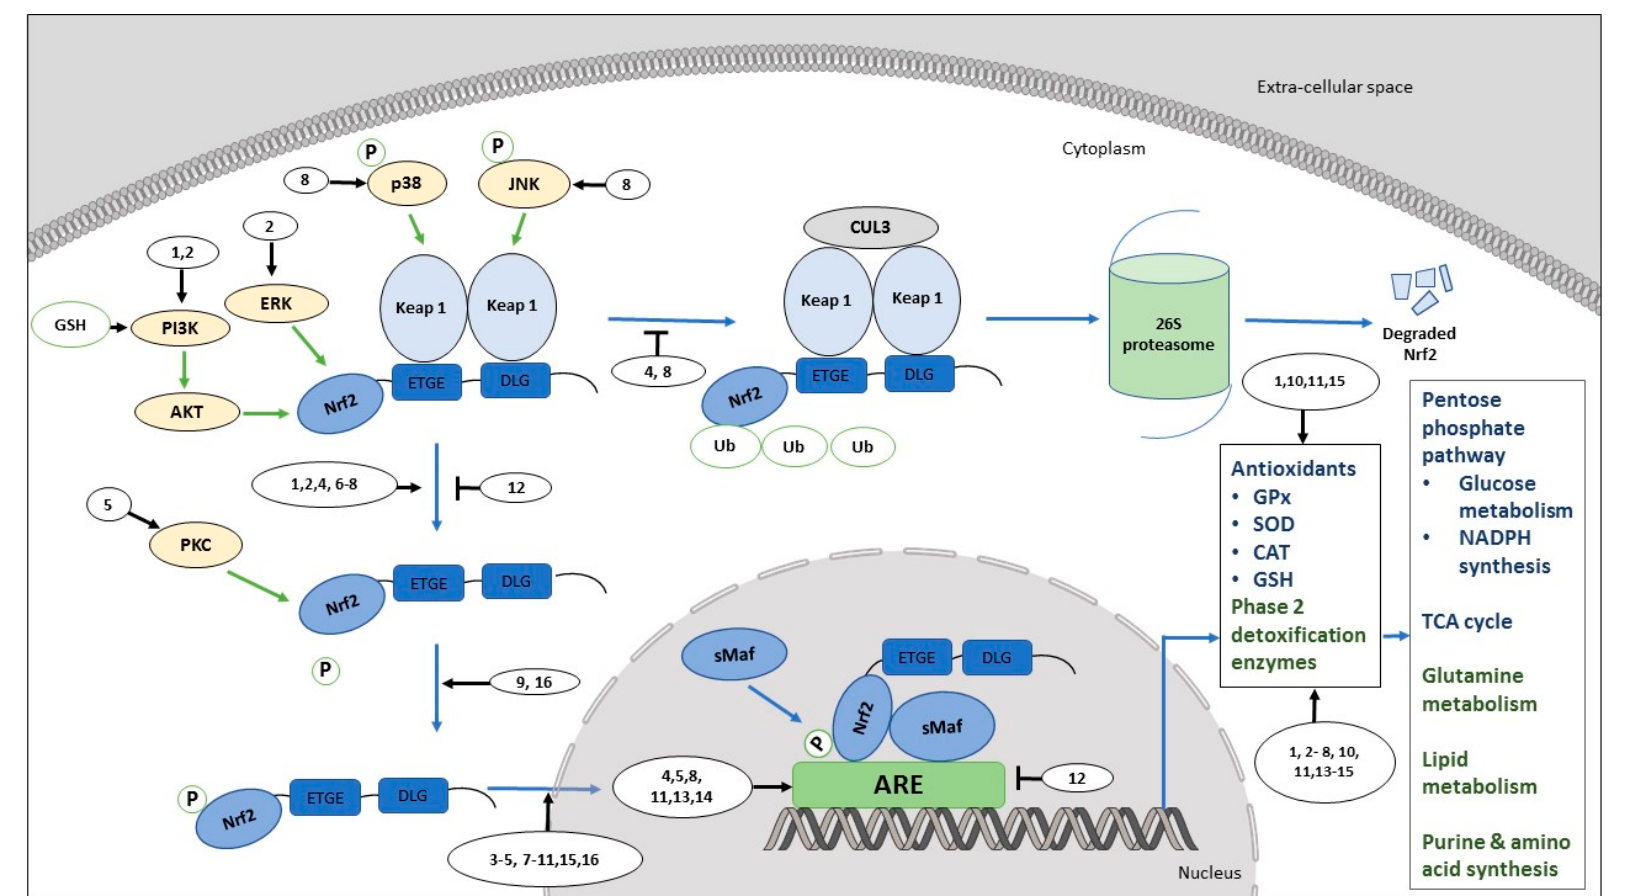
Figure 2. Role of dietary flavonoids in the Nrf2/ARE pathway in cancer cells.